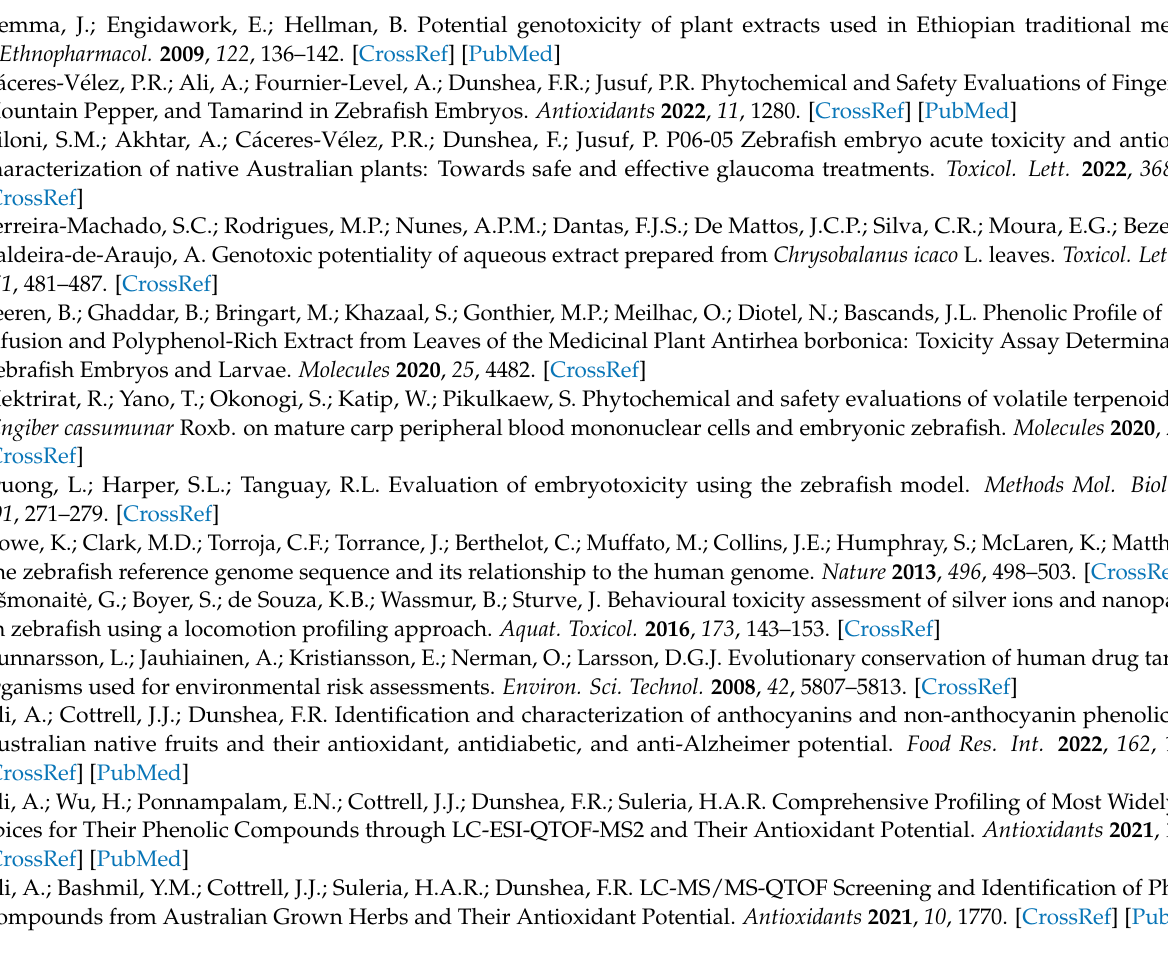
Australian fruits; Table S5: The estimated docking score (kcal/mol) and glide energy (kcal/mol) of phenolic metabolites in alanine aminotransferase